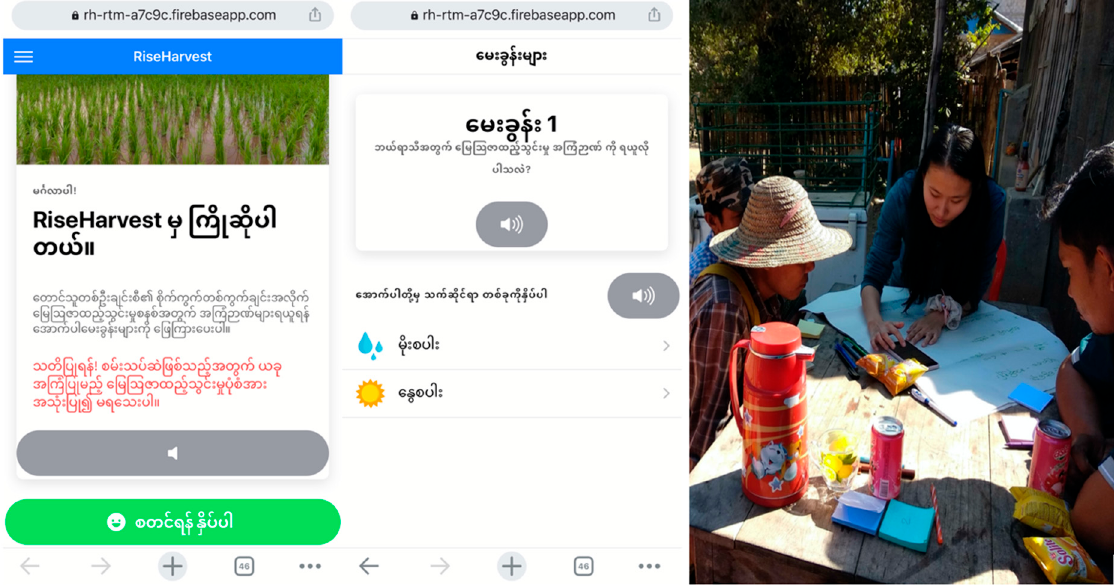
Figure 6. Prototype of RiseHarvest app used to demonstrate the concept of a DST to farmers in central Myanmar. Then farmers were asked “what information would be most helpful for you from a DST?” The answers varied among and between the farm types (Table 8). Table 8. Information most helpful to